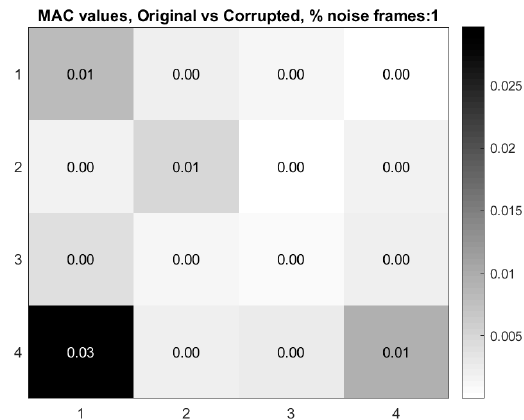
Figure 12. Modal assurance criterion (MAC) values comparing modes recovered from the original video with video for which 1% of the frames from the original video are replaced with Gaussian noise frames.